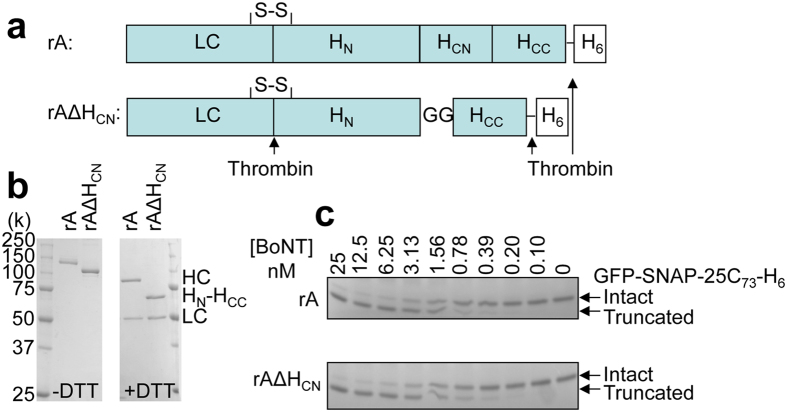
Expressed, purified rAΔHCN and rA showed similar proteolytic activity.(a) Schematic of rA and rAΔHCN. Nucleotides encoding I874-Q1091were deleted and replaced with 6 nucleotides GGCGGT to generate rAΔHCN. S-S denotes inter-chain disulphide, GG between HN and HCC in rAΔHCN represent glygly residues. H6 indicates 6xHis and (↑) represent consensus site for thrombin. (b) rAΔHCN and rA expressed in E. coli, purified and nicked before being subjected to SDS-PAGE in the presence or absence of DTT, followed by Coomassie staining. Note that HC and HN-HCC were separated from LCs only under reducing conditions. (c) rAΔHCN and rA exhibited similar protease activity towards a model GFP-SNAP-25C73-His6 substrate.